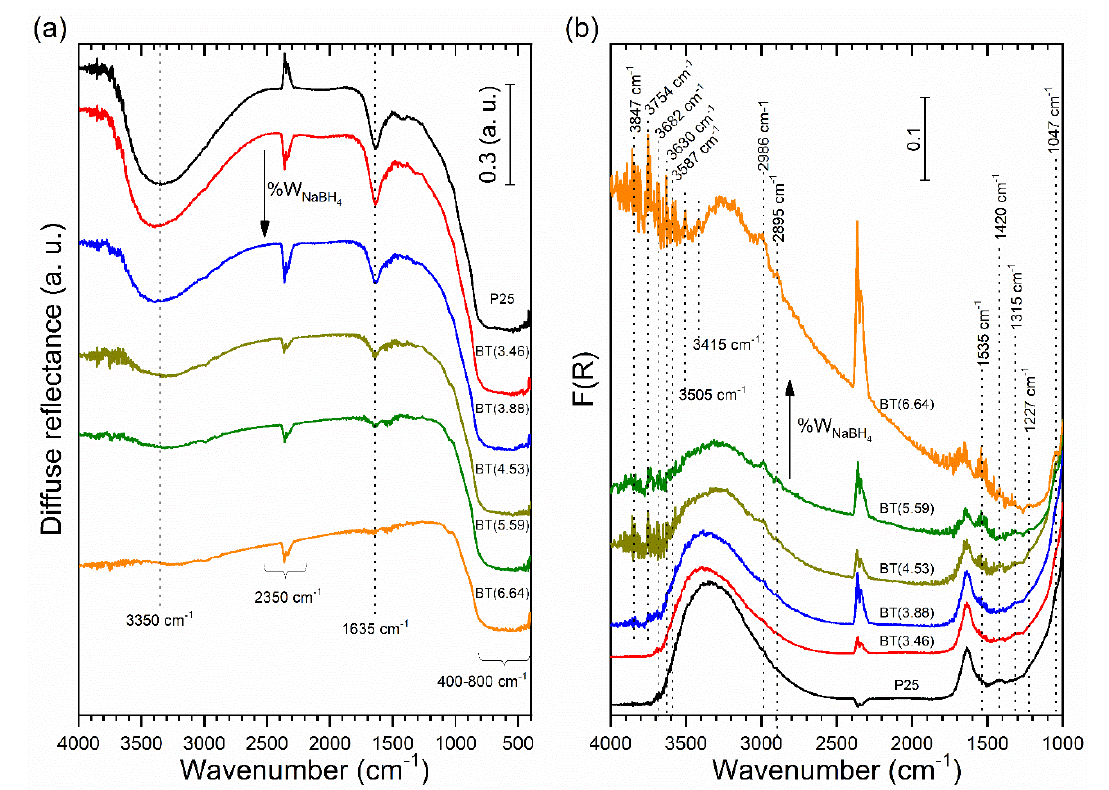
Figure 6. Infrared spectra of the prepared samples: ( a ) diffuse reflectance and ( b ) diffuse reflectance region transformed into Kubelka–Munk function. The ordinate axis of all spectra was shifted upwards for clarity.